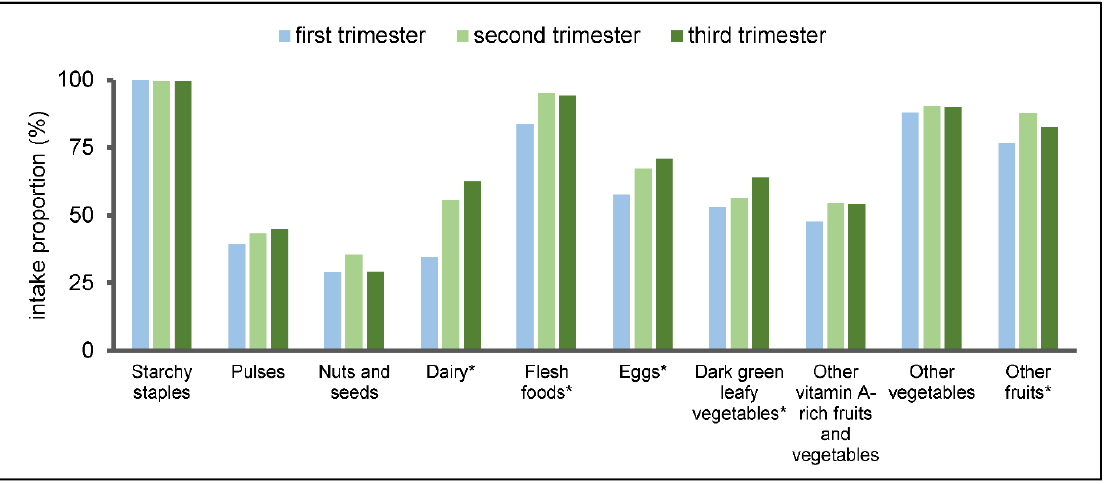
Figure 1. Proportions of food group consumption in the different trimesters. * Significant difference of food group intake proportion in the three trimesters ( p < 0.05). Table 2. Proportions of food group consumption according to the dietary diversity score (DDS).